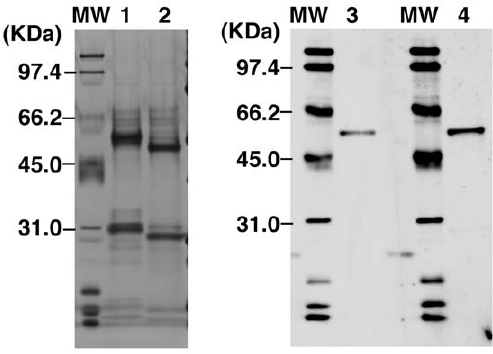
Figure 6. The integrity and the reactivity of the antibody produced by this method. SDS-PAGE of proteins produced by clone CN19-4/1F3. lane1, antibody purified from the clone CN19-4/1F3 culture; lane 2, commercial 9E10 c-MYC antibody; lane 3, immunoblot of the 50 kDa c-MYC fusion protein with the purified antibody from the CN19-4/1F3 culture (lane 3) or the commercial 9E10 c-MYC antibody (lane 4).